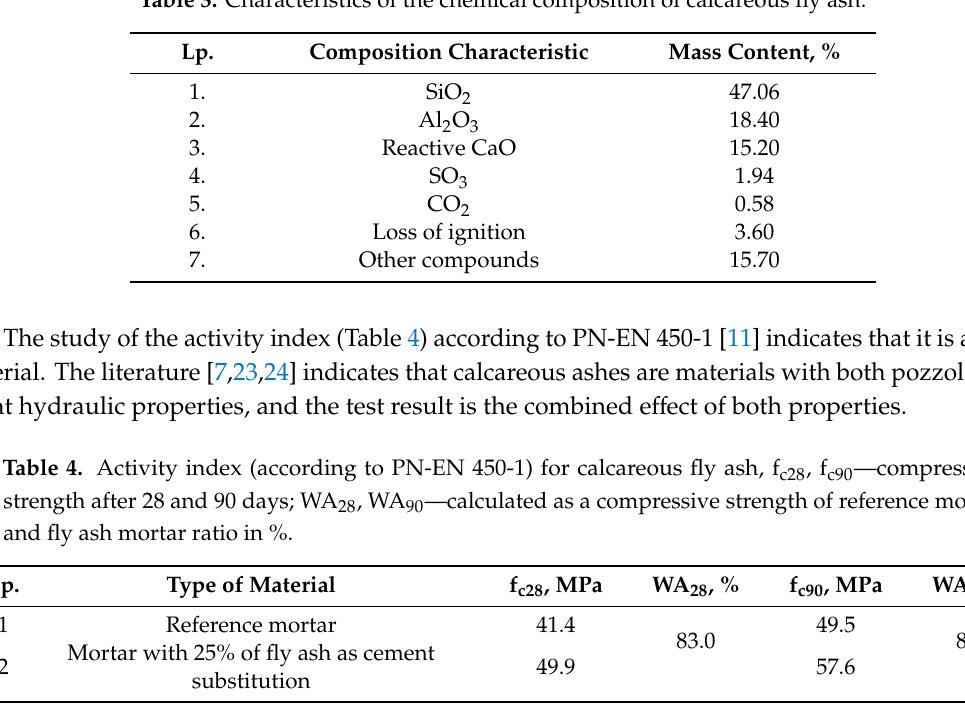
Table 3. Characteristics of the chemical composition of calcareous fly ash.